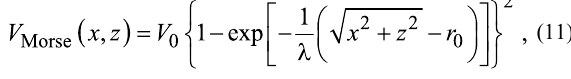
measured, force measurements require knowledge of k z